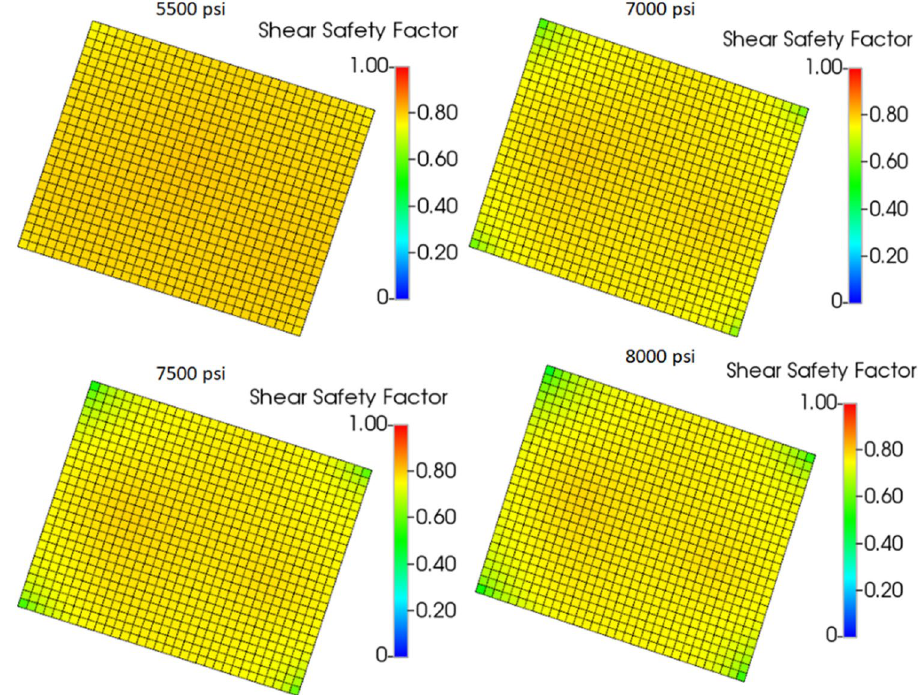
Figure 21. Shear safety factor in the bottom layer (Layer 5) of the